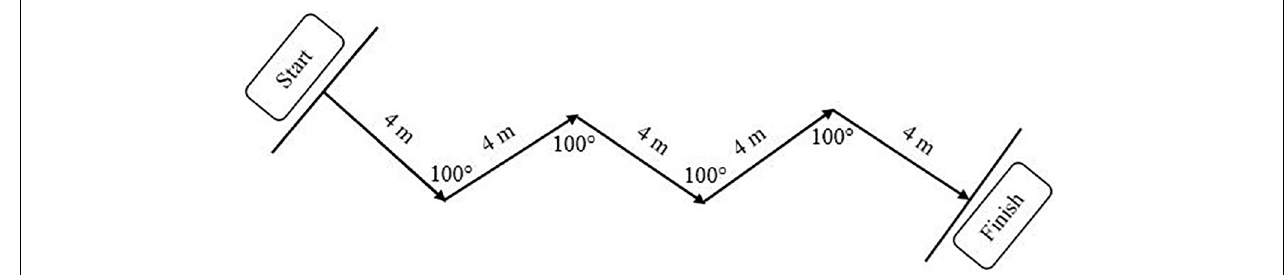
FIGURE 4 | Repeated change-of-direction test design.